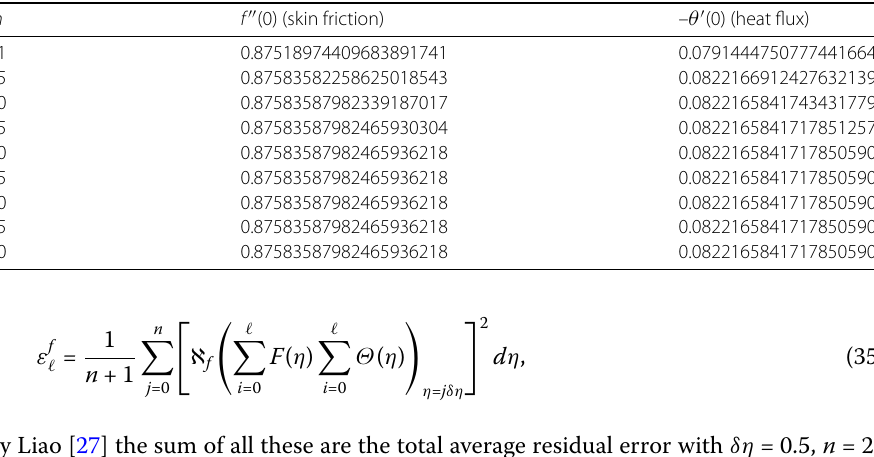
Table 3 Convergence of HAM on the basis of skin friction f (cid:7)(cid:7) (0) and heat flux – θ (cid:7) (0) for selected values of β = 0.2, I 0 = 0, λ = 0.2, A = 0.3, N = 0.2, S = 0.4, Ma = 1, M = 1, Υ = 0.127013, Pr =